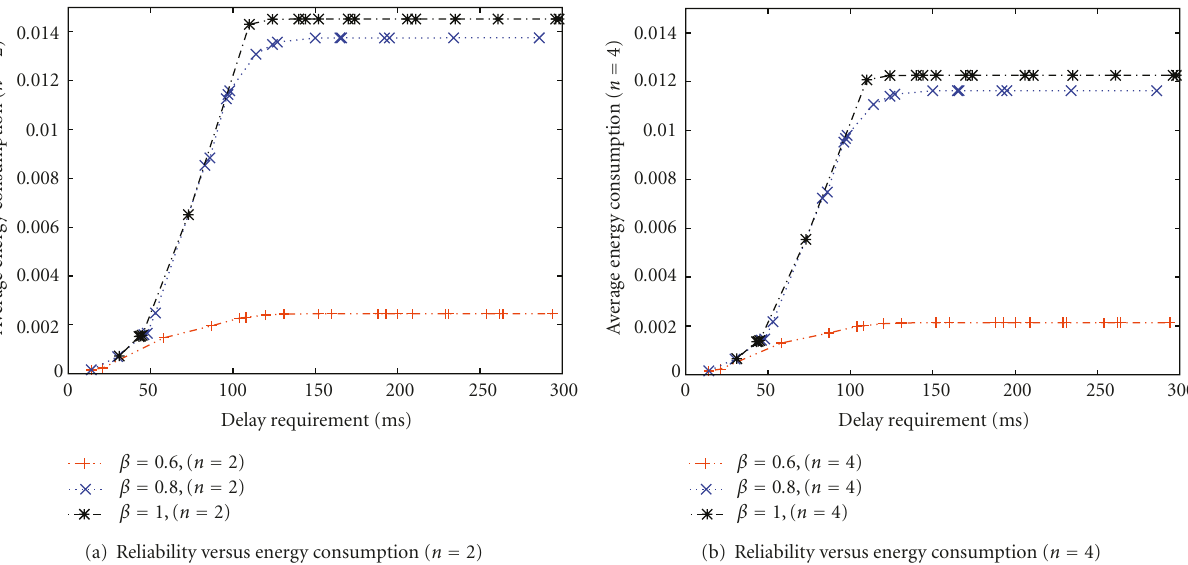
Figure 8: The impact of reliability on TE